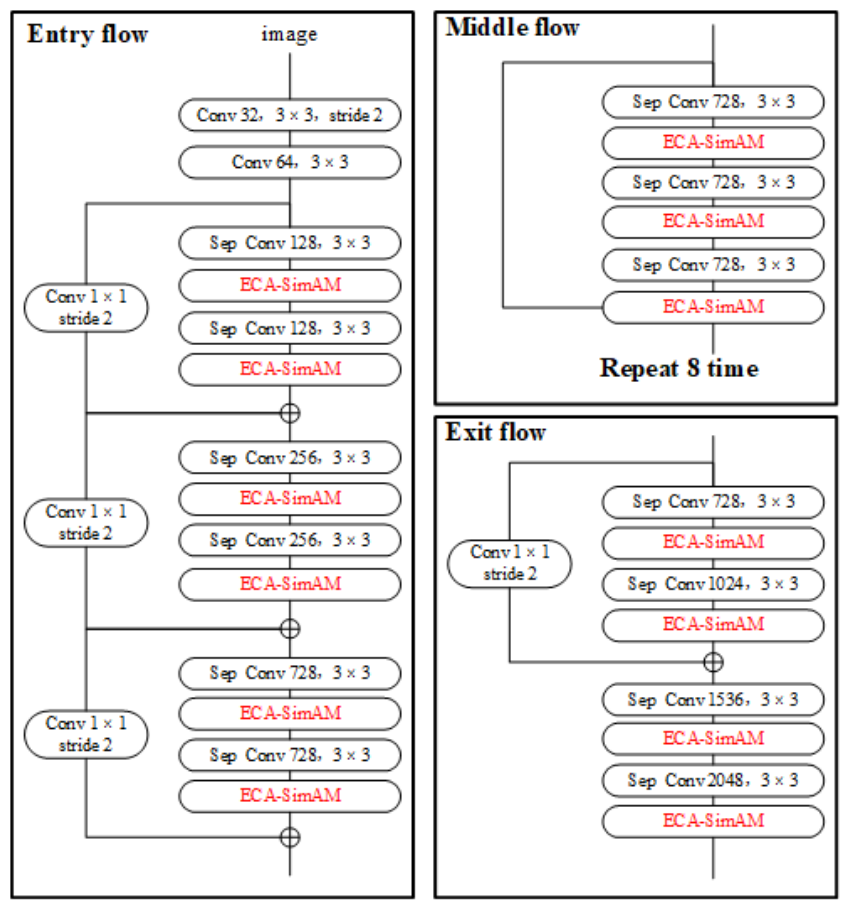
Figure 8. Dual-attention mechanism to optimize the backbone network.